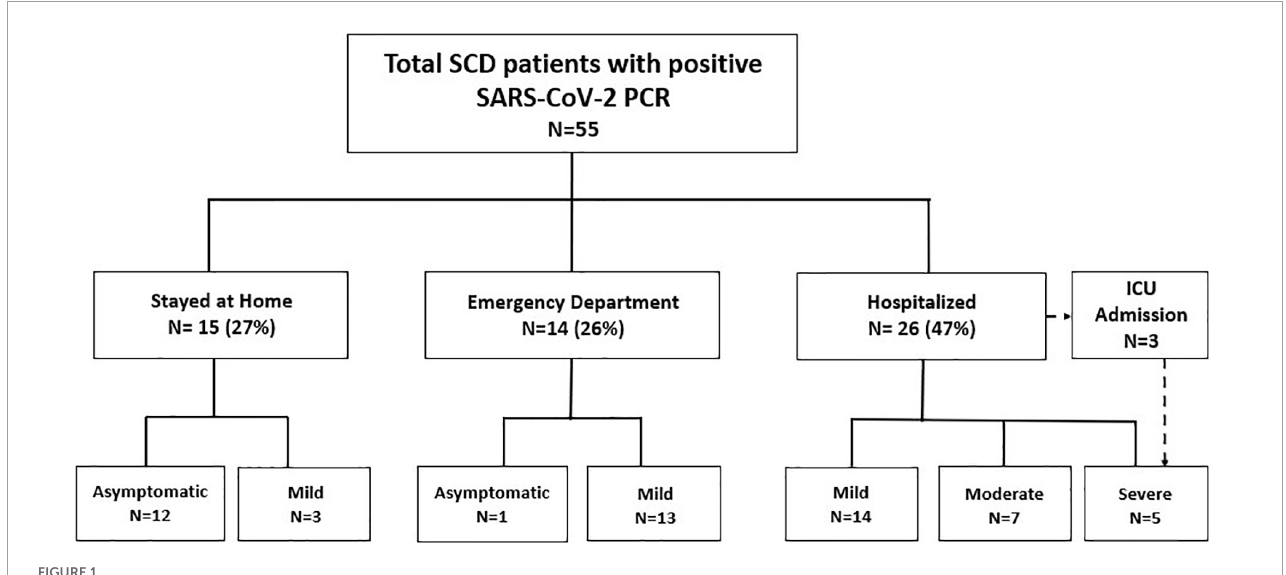
FIGURE1 Healthcare